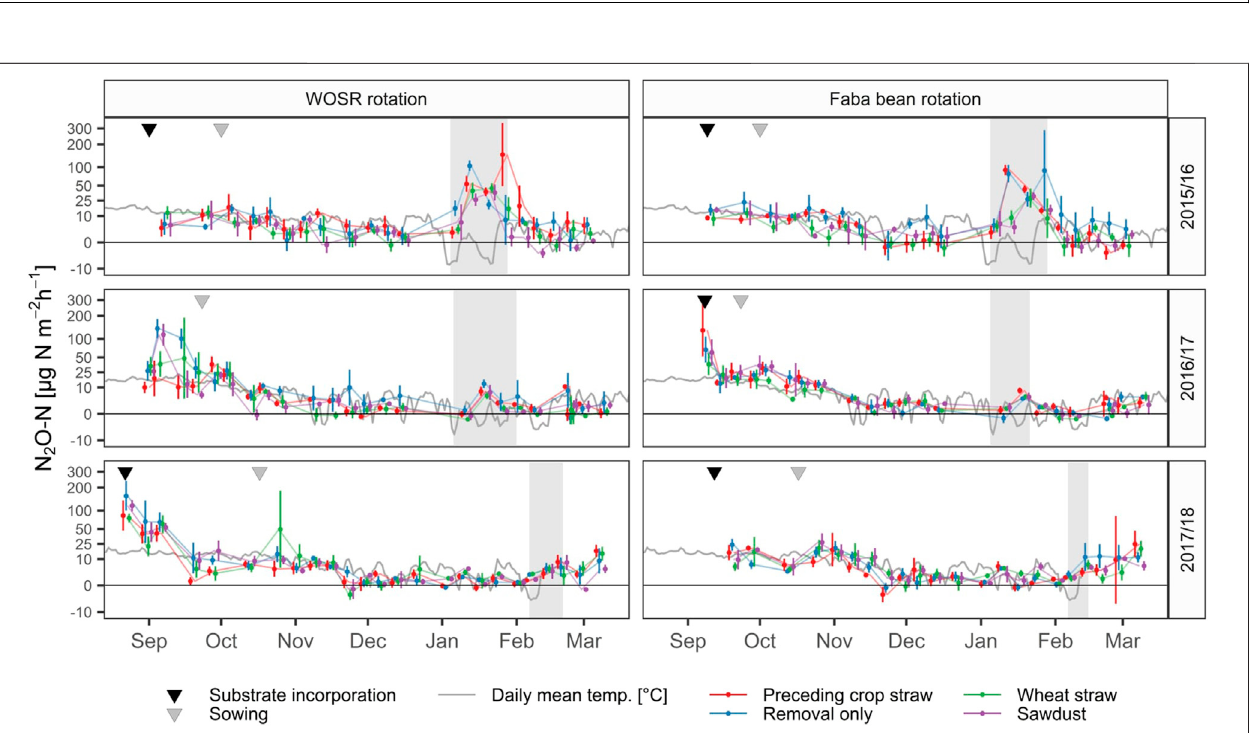
FIGURE 6 | N 2 O-N fl ux rates per treatment and season; points are mean values; lines represent linear interpolation; error bars indicate ± standard error; y -axis scaled after modulus transformation (John and Draper, 1980); freeze – thaw events are highlighted with gray background.